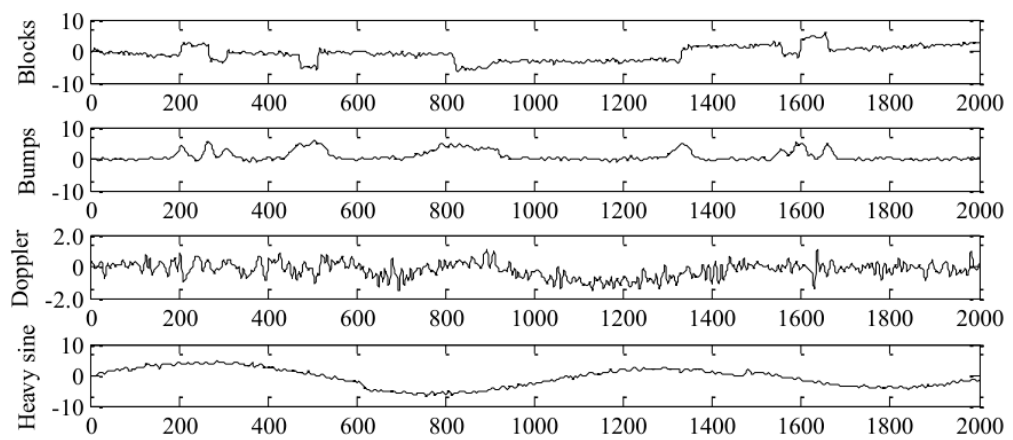
Figure 4. Results of wavelet denoising (the original signal SNR: 4dB).